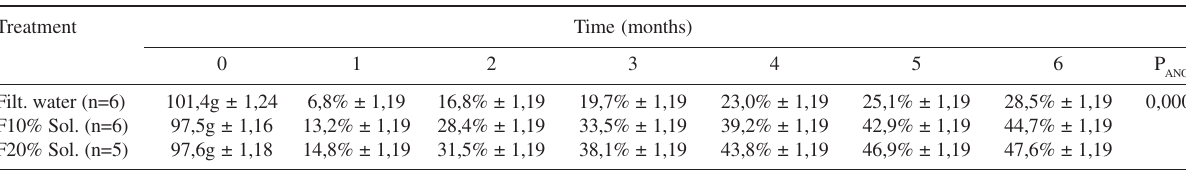
Table 3 - Variation of body weight (g) in animals treated for 6 months with filtered water, 10%, or 20% fructose solution and the standard laboratory diet. Results are expressed as mean ± SEM.